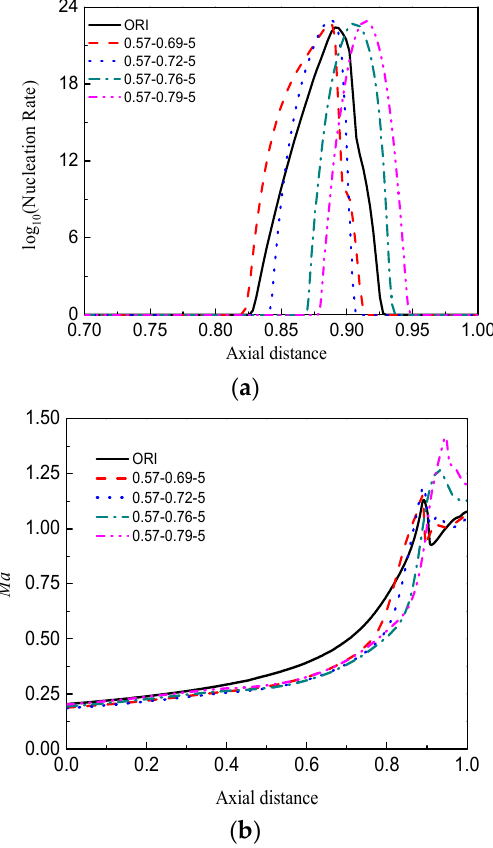
Figure 6. Distribution of steam parameters in the middle of the cascade passage (part 1): ( a ) nucleation rate; ( b ) Mach number.